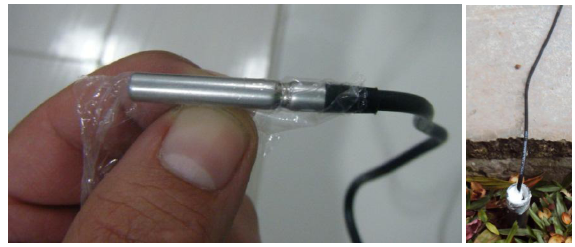
Figure 3: Sensor (left) and sensor-tube assembly inserted in the soil.